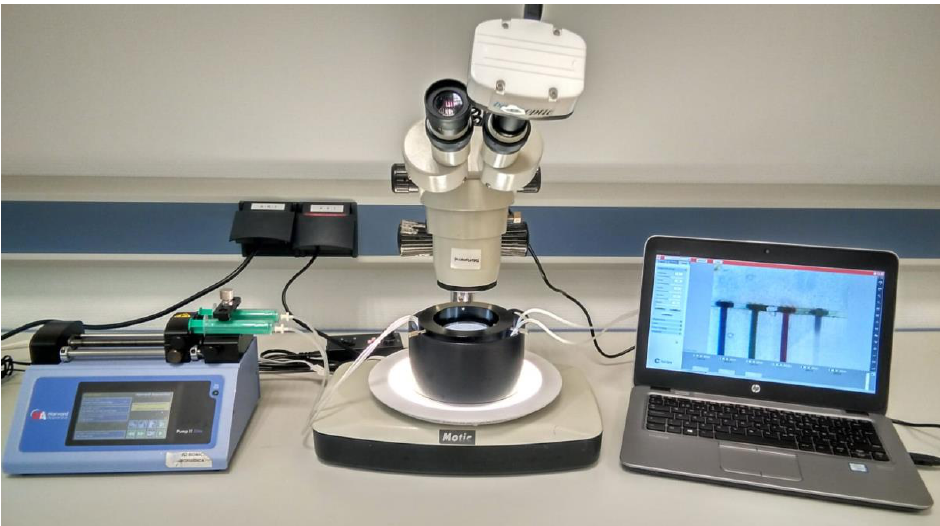
Figure 2. Set-up used for the characterisation of the sensor.